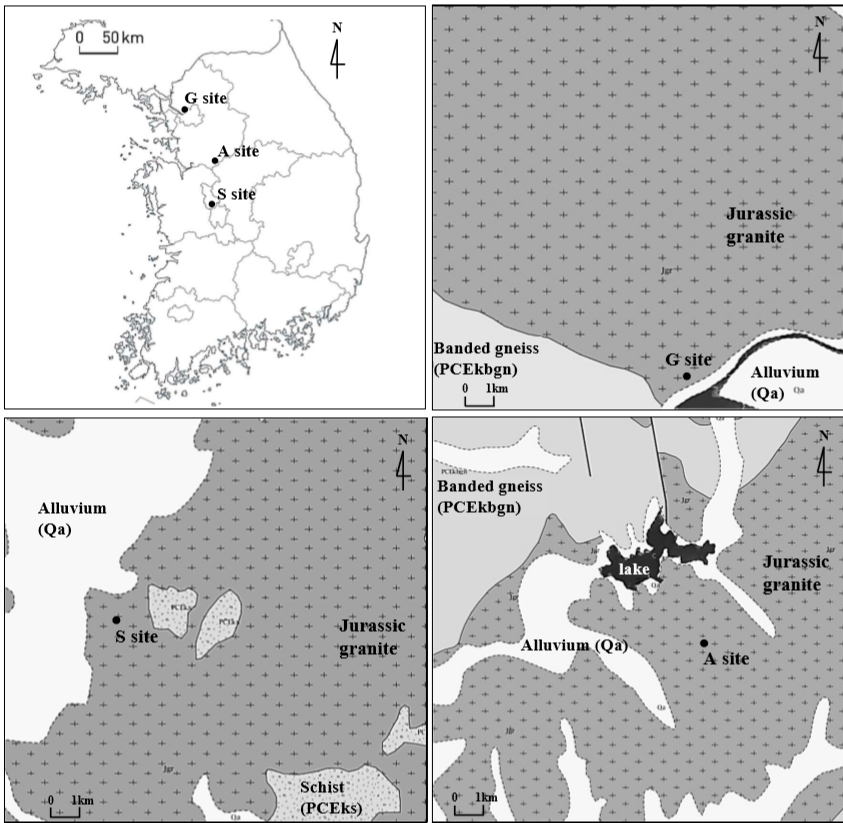
Figure 1. Locations and geological maps of test sites.